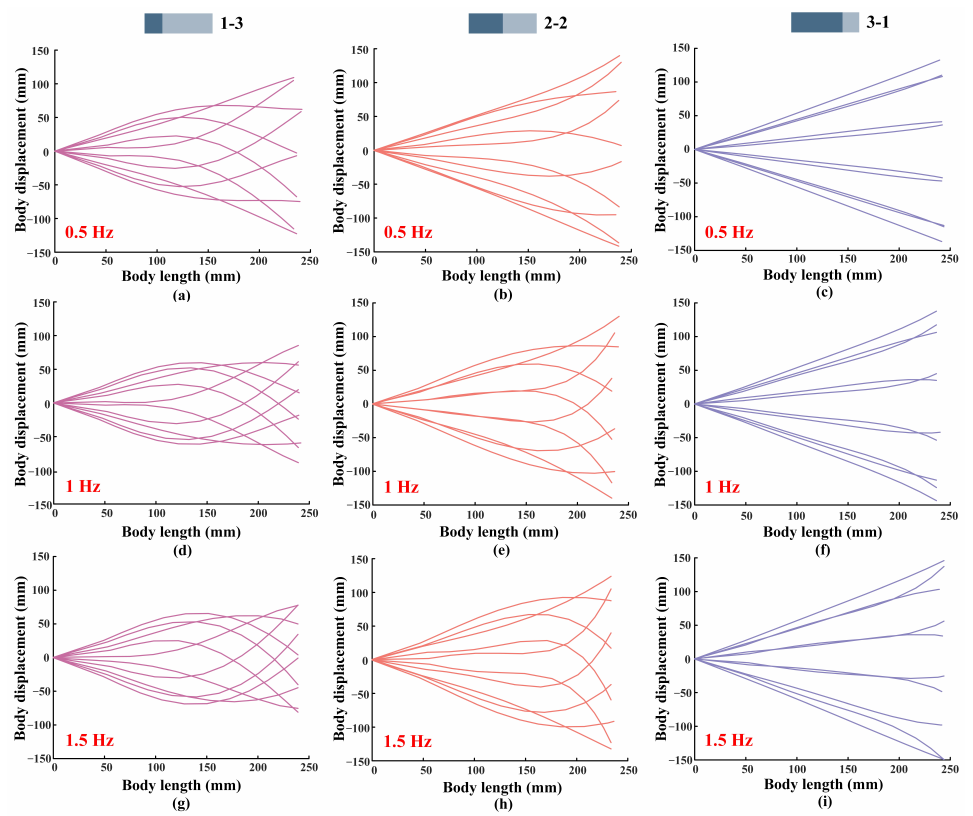
Figure 10. The displacement curves of the models. The flapping frequencies of the foil are set to 0.5 Hz, 1 Hz, and 1.5 Hz, the flapping amplitude is fixed at 30°, and the thickness of the flexible posterior border is 0.5 mm.